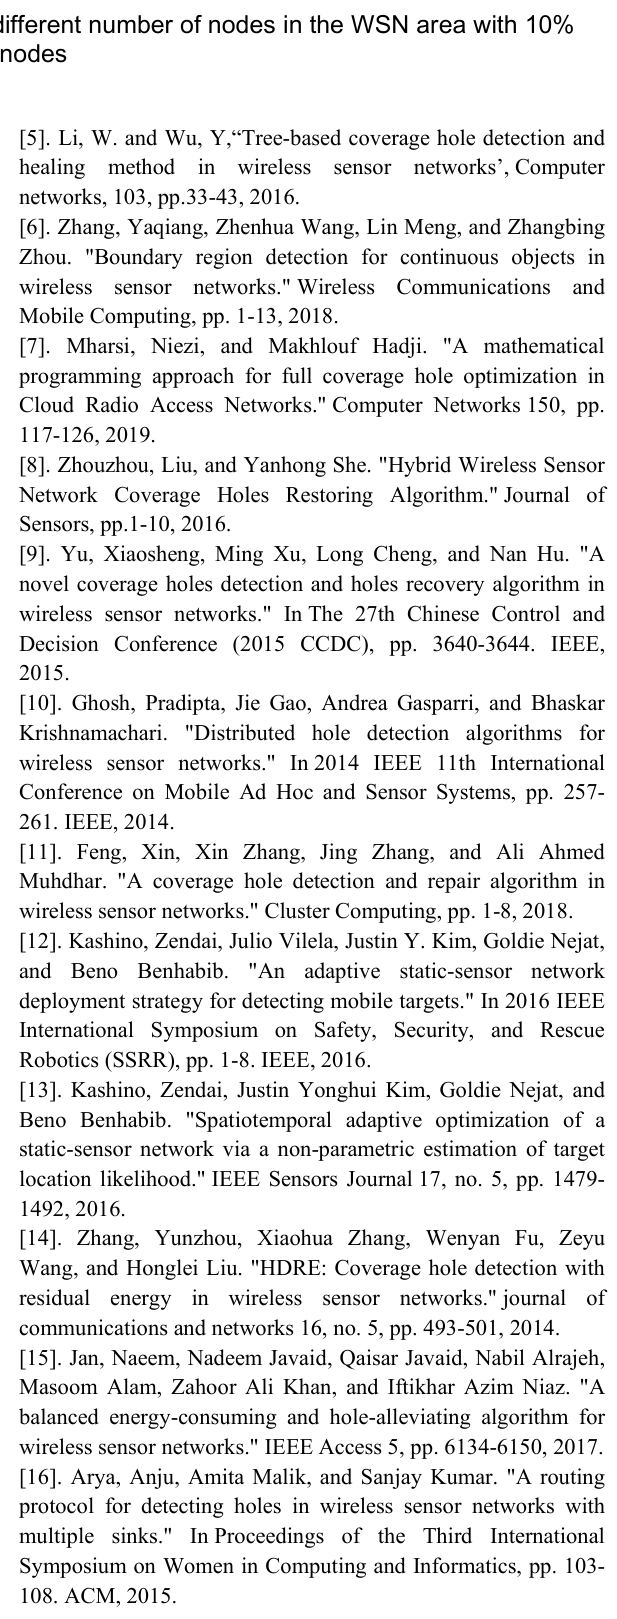
Figure 8. Validation of proposed hybrid optimization for different number of nodes in the WSN area with 10% redundant